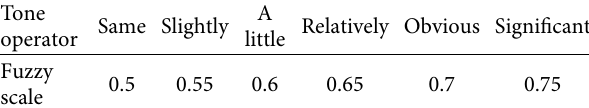
Table 2: Corresponding